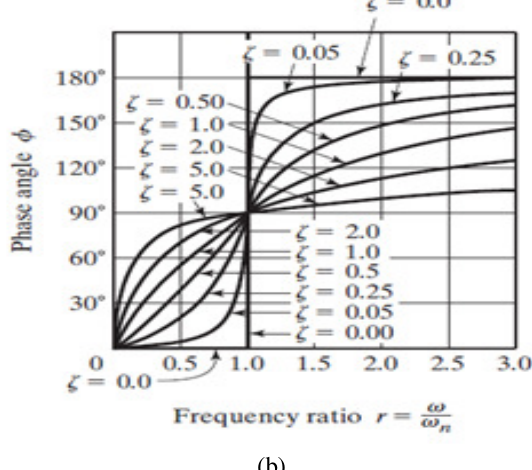
Fig. 4. Overview of the mechanical vibration shaker.